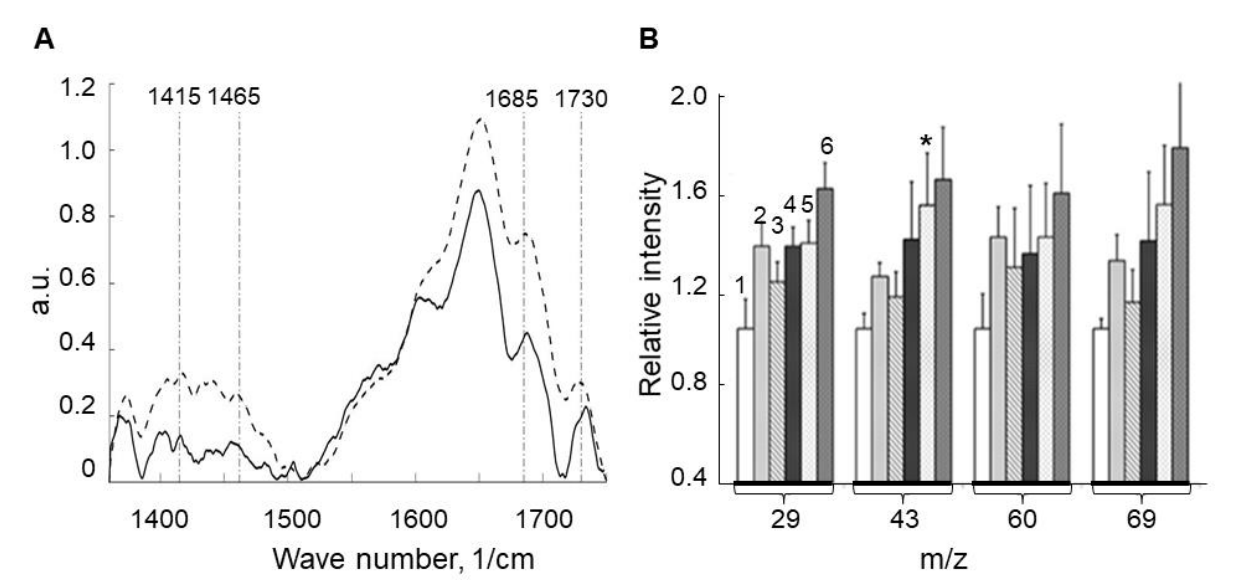
Figure 5. ( A ) Averaged Raman spectra for lipofuscin granule (LG) suspensions before (solid line) and after (dotted line) visible light irradiation for 100 min. Three independent experiments were conducted. In each experiment, 25 spectra were obtained ( p < 0.05). ( B ) Time-of-flight secondary ion mass spectrometry (ToF – SIMS) analysis of LG suspensions before irradiation (1) and after visible light irradiation for 2 (2), 10 (3), 40 (4), 100 (5), and 160 (6) min. On the abscissa axis, the numbers correspond to the mass of positive fragment ions, containing carbonyl groups (29: CHO+; 43: C 2 H 3 O+; 60: C 2 H 4 O 2 +; 69: C 4 H 5 O+). On the ordinate axis, the relative intensities of the corresponding positive fragment ions are plotted as relative units. Data are presented as means ± SD from nine independent experiments. * р < 0.01.